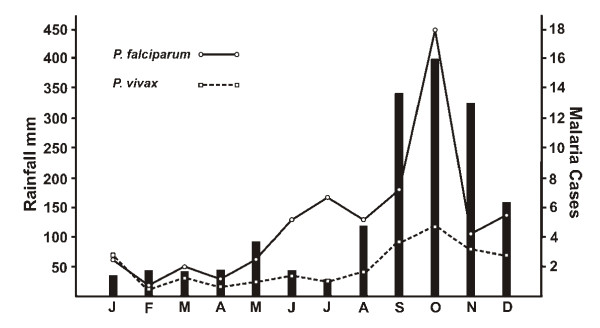
Monthly rain fall data (mean of 10 years) and the mean monthly incidence of malaria (2003-2007) for Truong Xuan Commune.